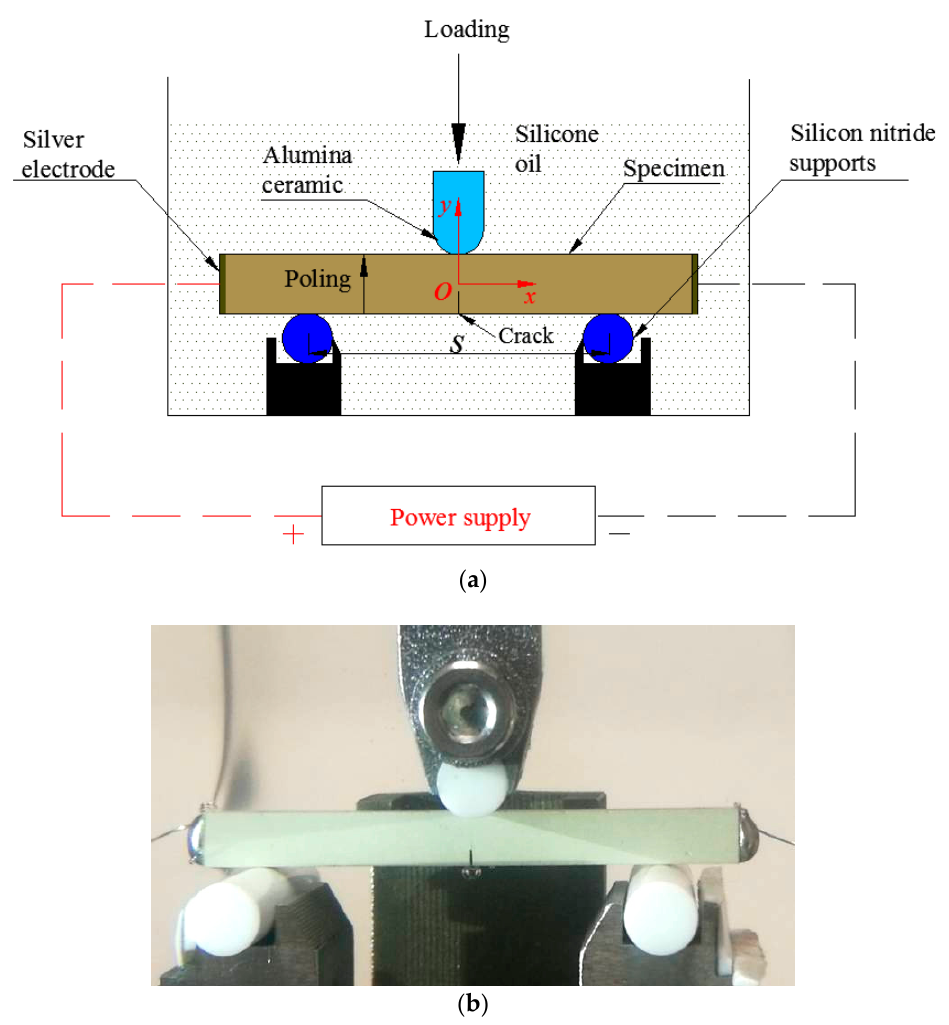
Figure 3. ( a ) Schematic representation of an experimental configuration and ( b ) an actual coupling experimental loading structure.